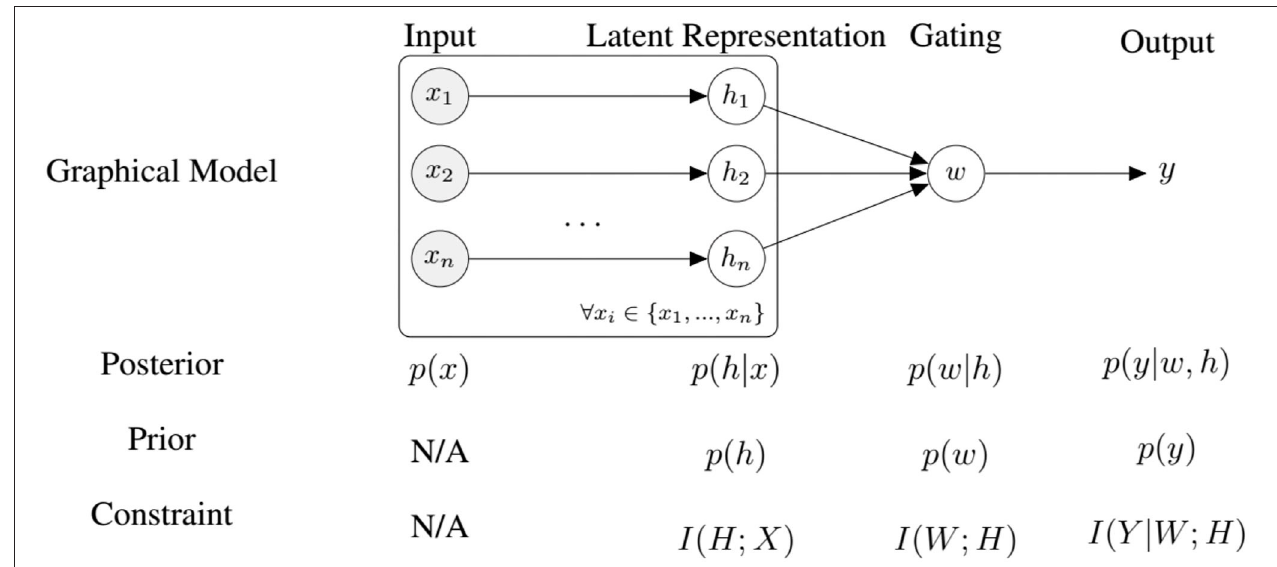
FIGURE 4 | An overview of our model for self-supervised fine-tuning and the corresponding information-processing constraints, where n is the number of modalities.